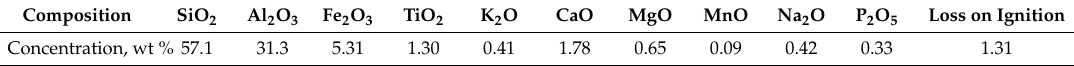
Table 1. Chemical composition of coal fly ash of Ekibastuz’s SDPS-1, the Republic of Kazakhstan. Composition SiO 2 Al 2 O 3 Fe 2 O 3 TiO 2 K 2 O CaO MgO MnO Na 2 O P 2 O 5 Loss on Ignition Concentration, wt % 57.1 31.3 5.31 1.30 0.41 1.78 0.65 0.09 0.42 0.33